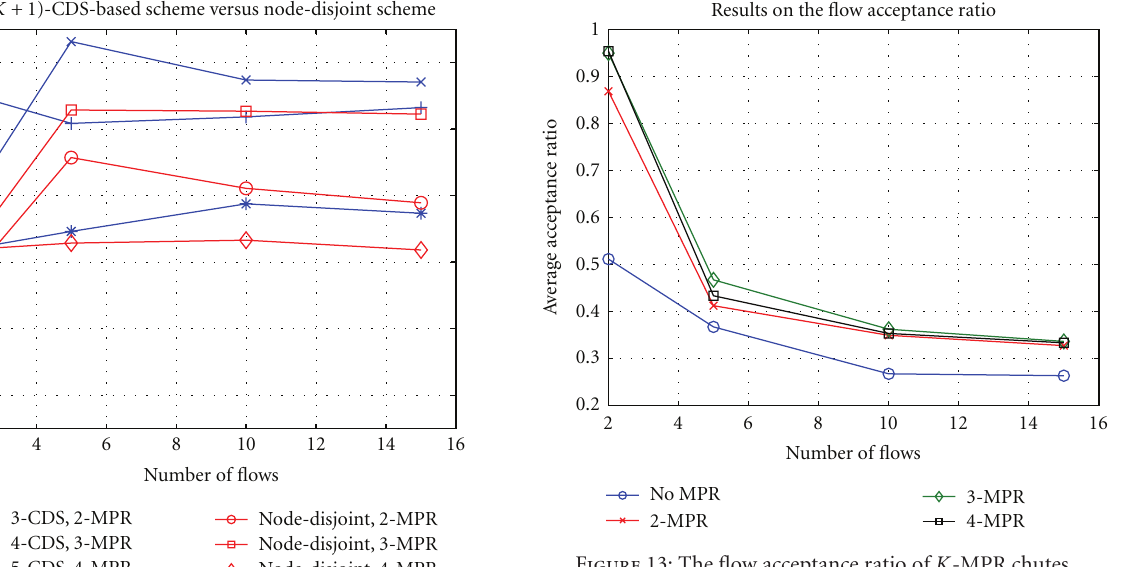
Figure 13: The flow acceptance ratio of K -MPR